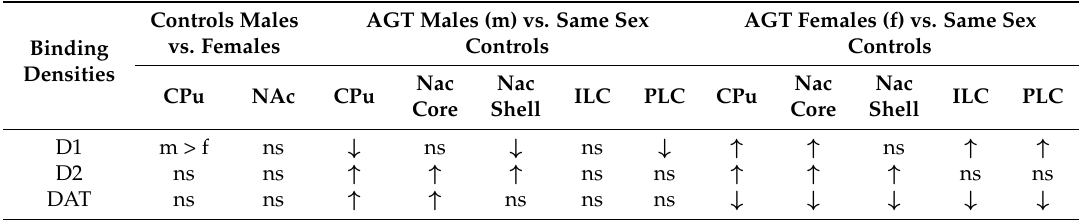
Table 1. Summary of autoradiographic analysis of changes in dopaminergic signalling proteins after antenatal glucocorticoid treatment